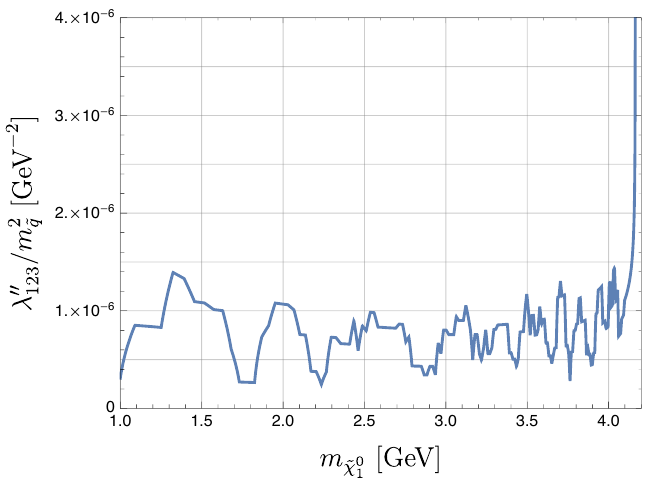
Figure 6 . Limits on λ 00 Λ 0 ψ D ) [60] reinterpreted in terms of B 0 → Λ 0 ˜ χ 0